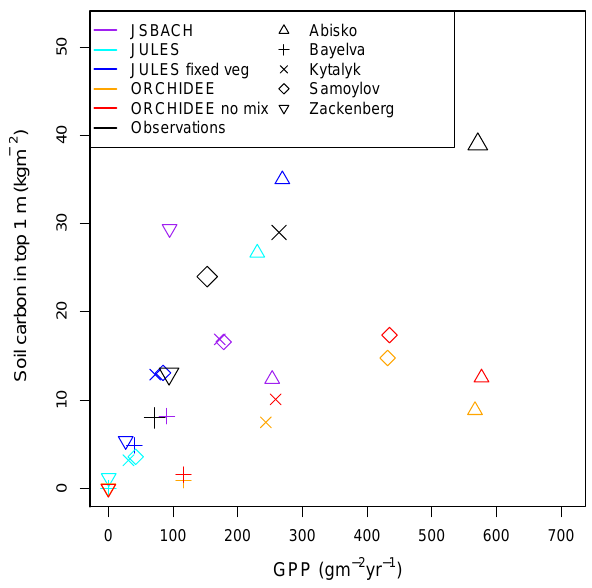
Figure 6. GPP compared with the top 1m soil carbon at each site. The top 1m soil carbon values are for the tower footprint area (see Table S2), so that equivalent values are being